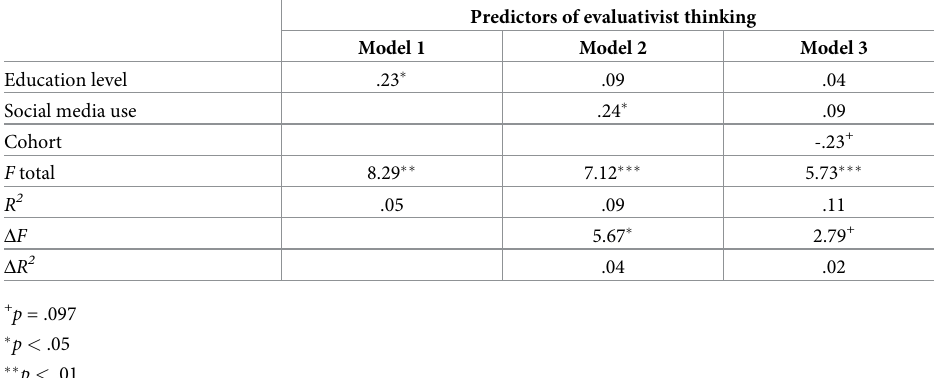
Table 4. Hierarchical regression: Predictors of evaluativist